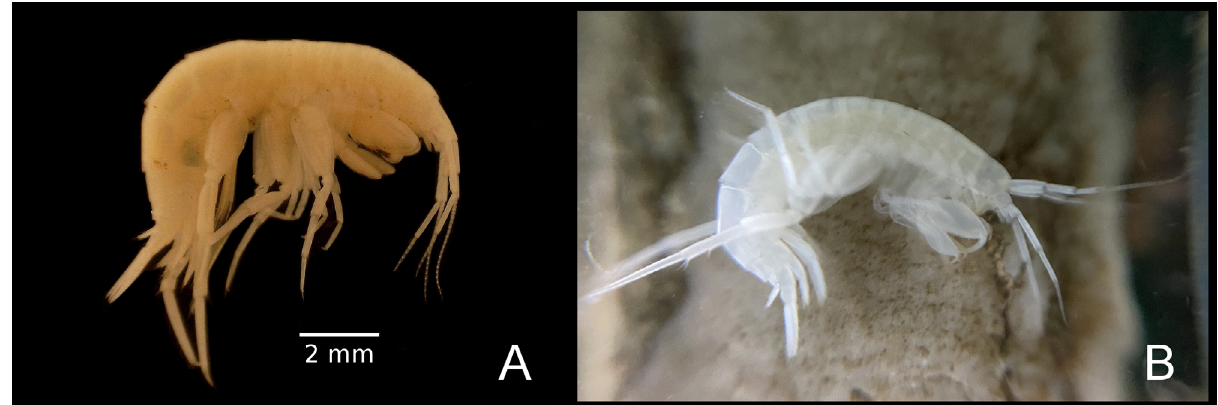
Figure 1. Preserved ( A ) and live specimen ( B ) of Spelaeogammarus ginae sp. nov., Gruna da Serra Verde cave, Serra do Ramalho karst area, state of Bahia, Brazil. Photographs: ( A ) T. Zepon, ( B ) M.E.